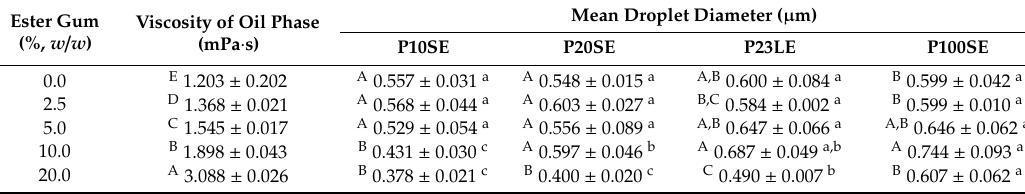
Table 1. E ff ect of ester gum concentration in the oil phase on the apparent viscosity and the initial droplet diameters ( d 43 , µ m) of orange oil emulsions stabilized using various emulsifiers.